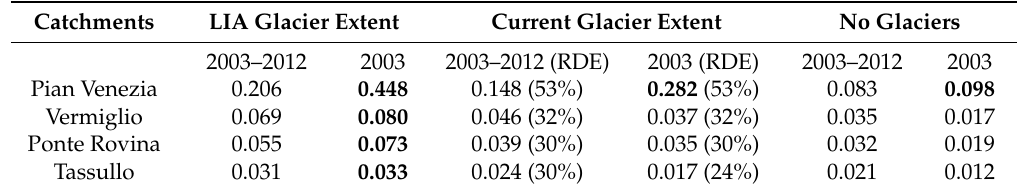
Table 5. Unit discharge (m 3 s − 1 km − 2 ) in August during the decade from 2003 to 2012, and in 2003. Value in bold indicate 2003 unit discharge larger than average 2003–2012 unit discharge. Residual damping effect (RDE) for the Current glaciers are shown in